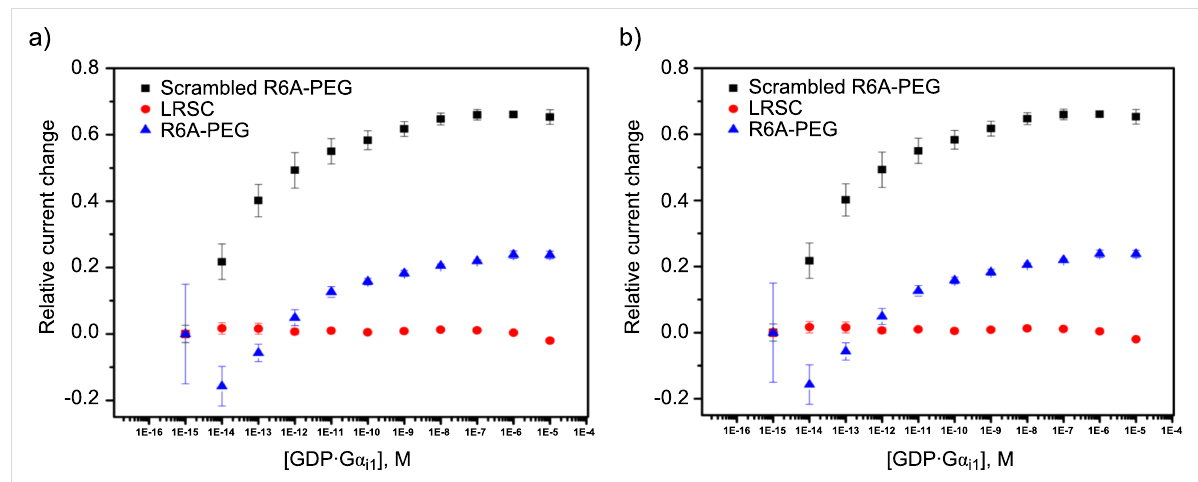
Figure 1. YM and FR bind the alpha-subunit of the